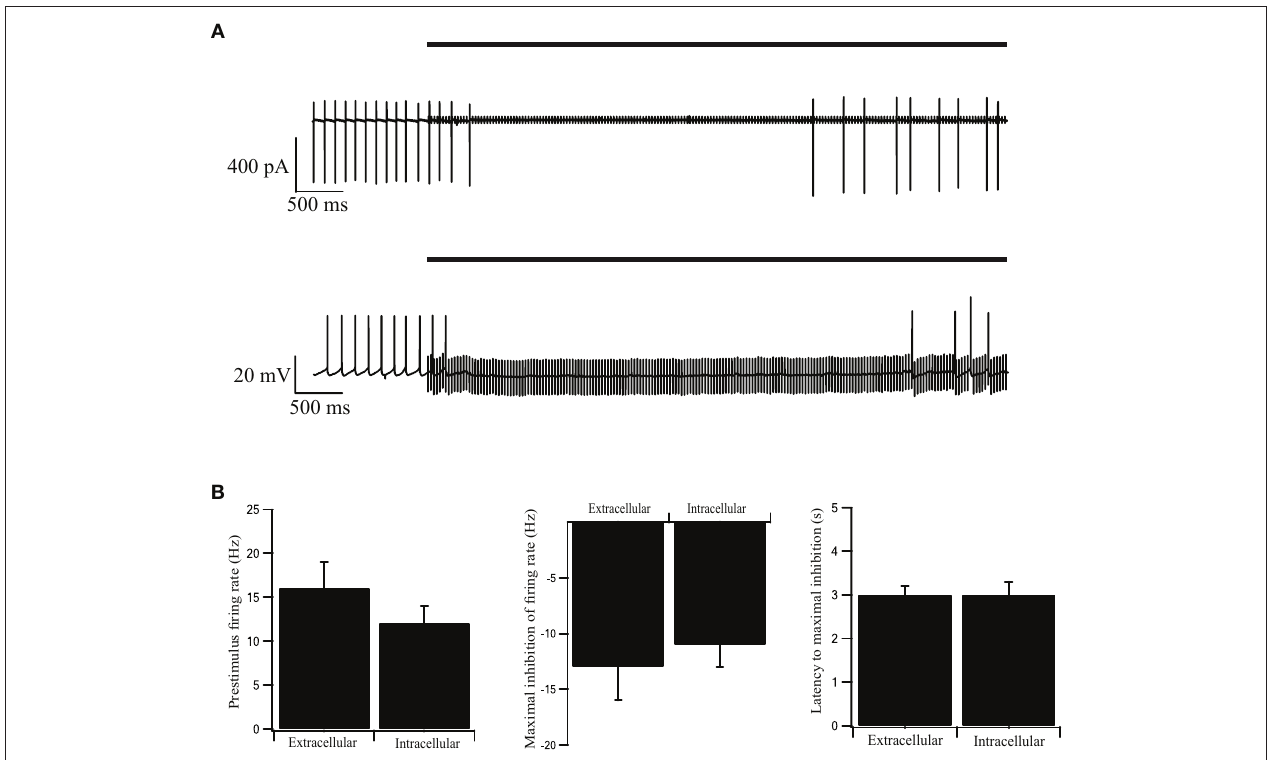
of 20 to enable a clearer view of the extracellular spikes. The bold horizontal lines indicate the period of repetitive stimulation. (B) Extracellular and intracellular average pre-stimulus firing rate, inhibition of firing rate, and latency to maximal inhibition, recorded in the cell-attached, and whole-cell modes across the population of neurons in GP ( n = 12). Error bars are expressed as mean